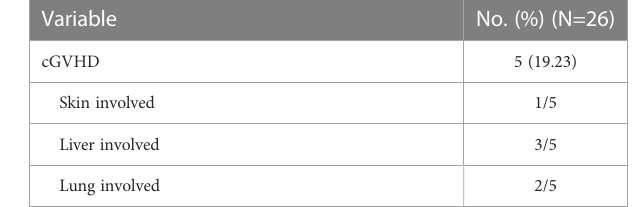
TABLE 3 Characteristics of patients in HSCT